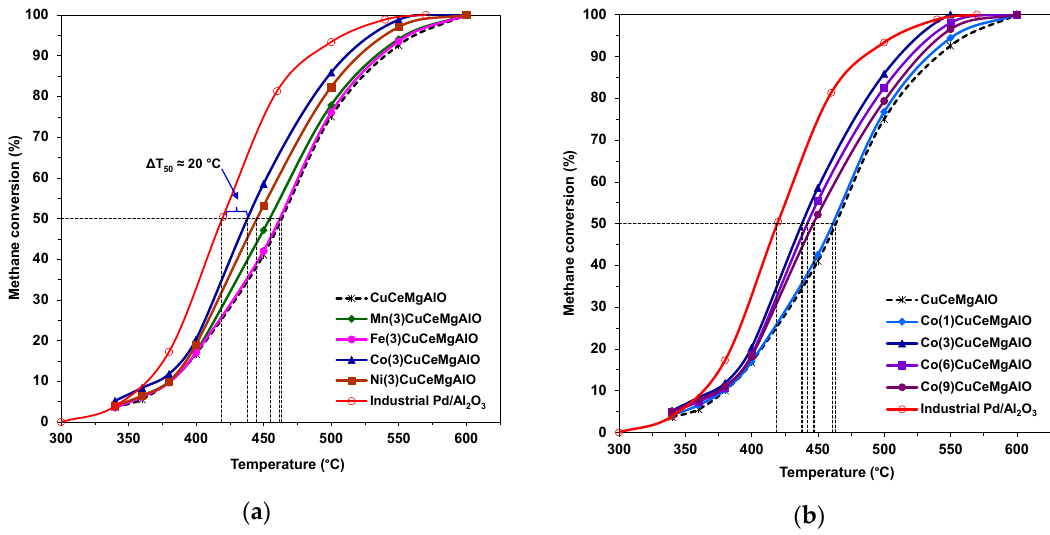
Figure 10. The light-off curves for the combustion of methane over ( a ) M(3)CuCeMgAlO and ( b ) Co(x)CuCeMgAlO mixed oxide catalysts compared with that of a reference Pd/Al 2 O 3 catalyst. Table 7. Catalytic performance in the total oxidation of methane of the LDH-derived mixed oxides.